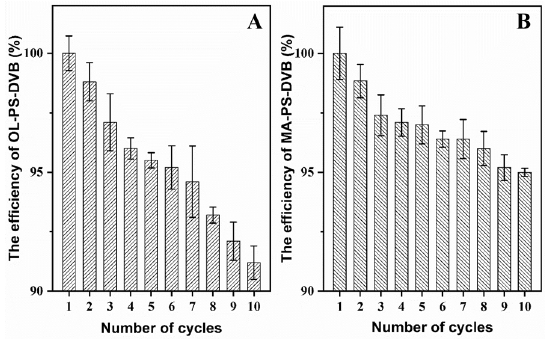
Fig. 6 The efficiency of recycled OL‑PS‑DVB and